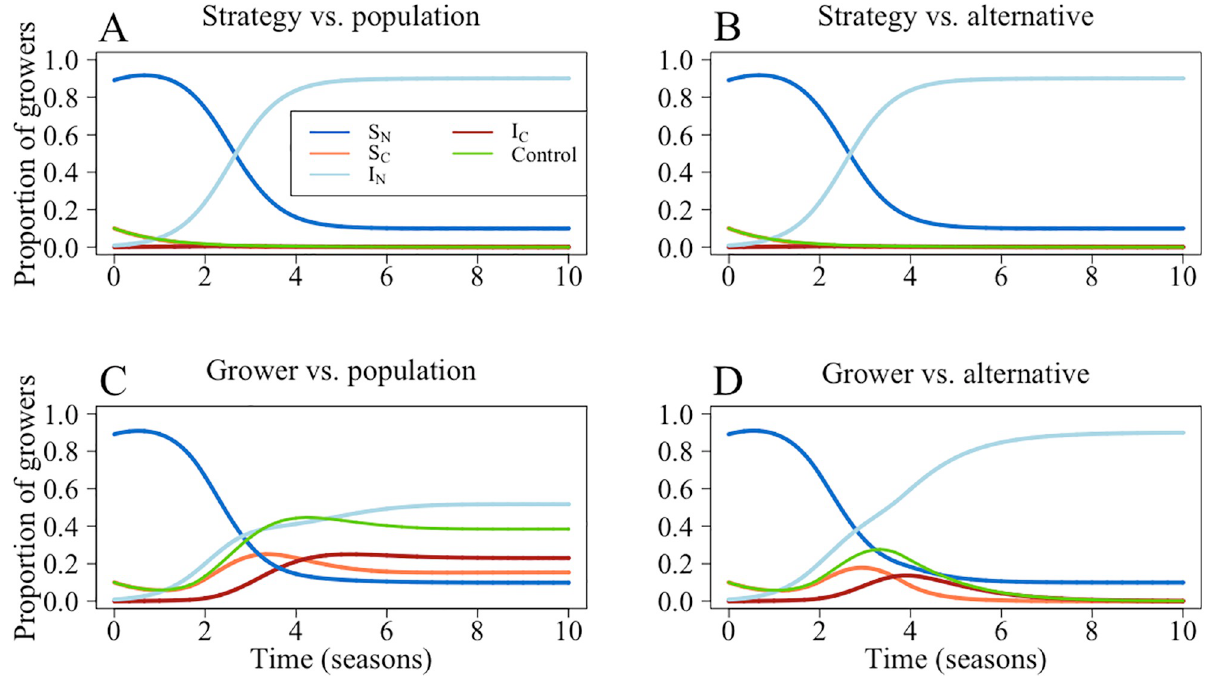
Fig 3. Model dynamics for different means of comparison. Here, S N are susceptible non-controllers, I N infected non-controllers, S C are susceptible infected controllers. C represents S + I . In A, growers compare the expected profit of their strategy with that of the entire controllers and I C C C population; in B they compare the expected profit of their strategy with the expected profit of the alternative strategy. For C, growers compare their own outcome with expected profit of the population and in D they compare their outcome with the expected value of the alternative strategy. In A, B and D, no growers control for disease at equilibrium, though in C around 38% of growers control. Parameters are outlined in Table 1.